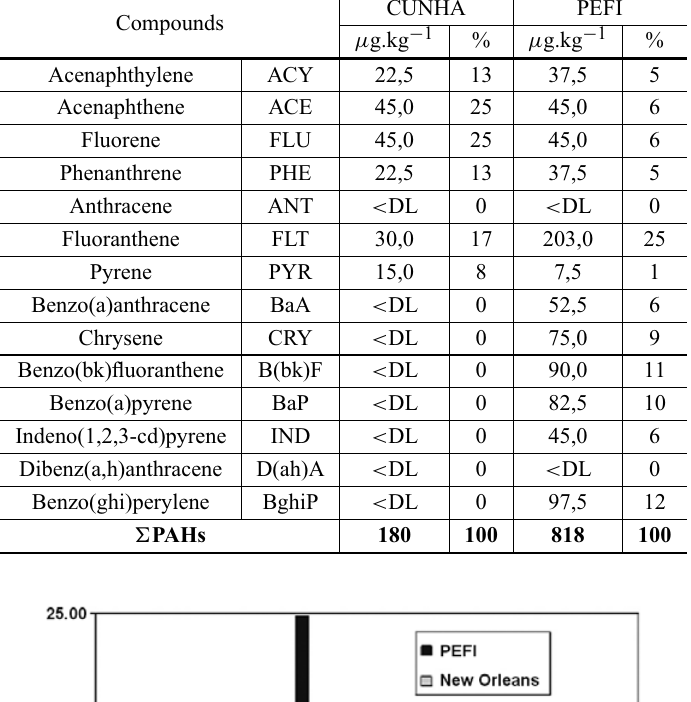
PAHs concentration values grated in the 0–20 cm topsoil horizons. ( < DL : lower than detection limit).